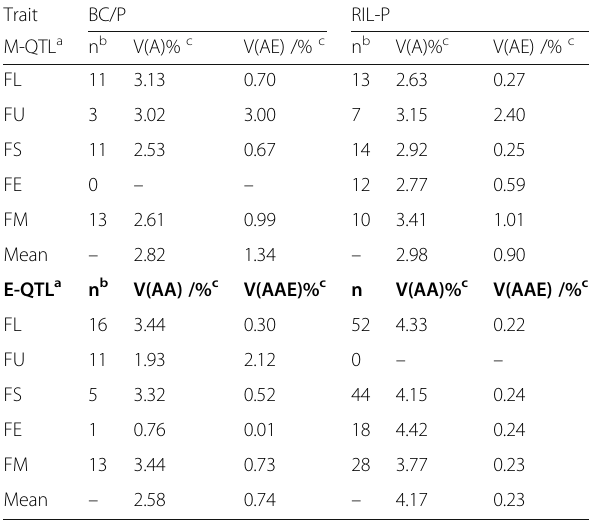
Table 4 Summary on M-QTL and E-QTLs controlling fiber quality traits in BC/P and RIL-P datasets in BC/P